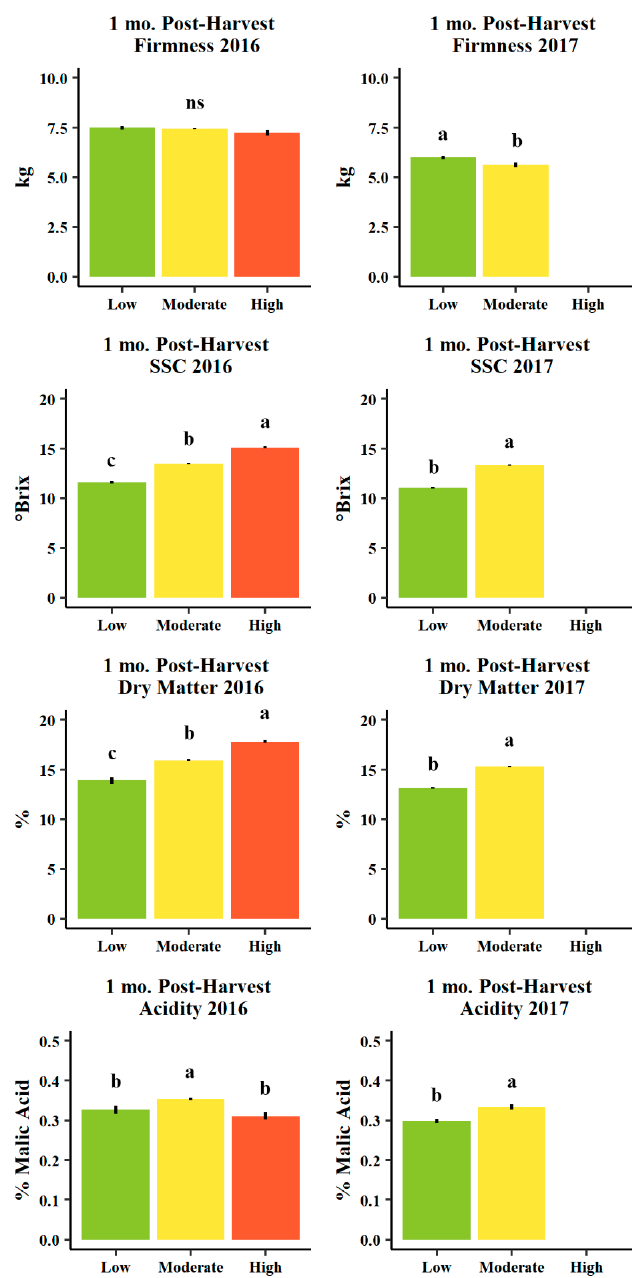
Figure 9. Mean firmness (kg, n = 457 and 253 in 2016 and 2017, respectively), soluble solids content (SSC, °Brix, n = 457 and 253 in 2016 and 2017, respectively), destructively measured actual dry matter (%, n = 95 and 173 in 2016 and 2017, respectively), and acidity (% malic acid, n = 57 and 45 in 2016 and 2017, respectively) for d’Anjou fruit evaluated one mo. post-harvest (within one month after harvest in cold storage plus seven days of ripening at room temperature) in 2016 ( left ) and 2017 ( right ) among Low ( < 13%, green), Moderate (13–16%, yellow), and High ( > 16%, orange) predicted dry matter categories. Error bars indicate ± standard error. Di ff erent letters indicate significance di ff erence among means ( p < 0.05, Tukey HSD). “ns” indicates no significant di ff erence among means ( p > 0.05, Tukey